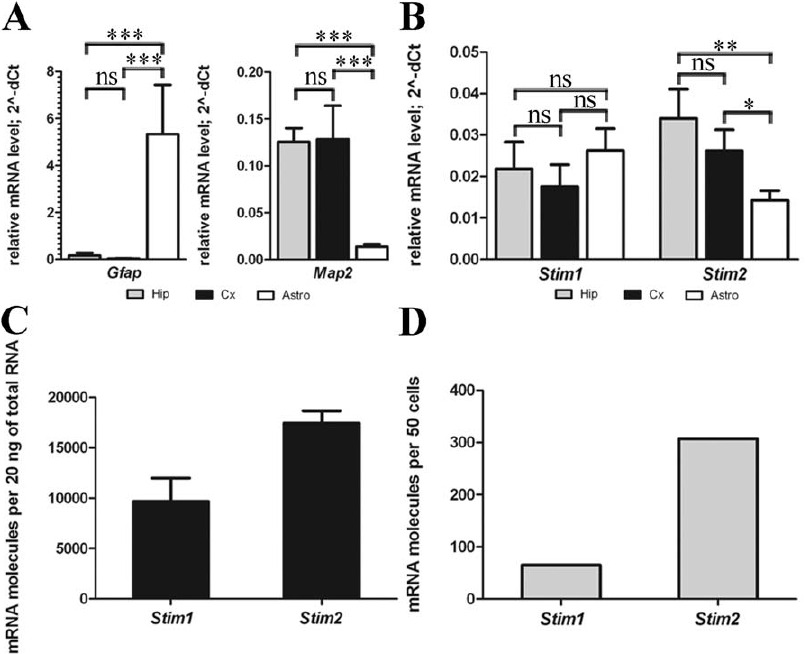
Figure 1. Real-time PCR analysis of Stim1 and Stim2 mRNA levels in neurons. mRNA was isolated from primary cultures of neurons and astrocytes. TaqMan primers and probes were used to quantify specific mRNA levels. ( A ) The Gfap astrocytic marker and Map2 neuronal marker are differentially expressed in cultures of cortical neurons (Cx), hippocampal neurons (Hip) and astrocytes (Astro), confirming the purity of the cultures. The expression was related to the Gapdh level set as 1 for every culture, using the 2 2 dCT formula (dCT=CT target 2 CT Gapdh ; CT is the cycle threshold). ( B ) Stim1 and Stim2 are expressed in neurons of the cortex (Cx) and hippocampus (Hip) and in cortical astrocytes (Astro). The expression was related to Gapdh as above. ( C ) The actual number of Stim1 and Stim2 mRNA molecules in 20 ng of RNA isolated from cortical neurons was quantified using a standard curve with serial dilutions of cloned Stim1 and Stim2 . ( D ) The actual number of Stim1 and Stim2 mRNA molecules in laser-dissected hippocampal neurons was quantified as